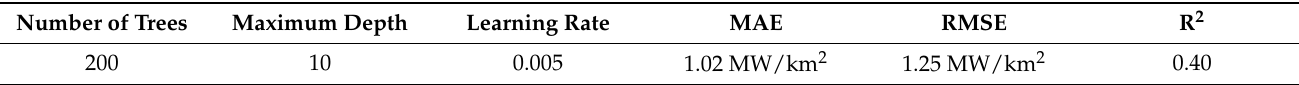
Table 3. Results for the best model including model configuration as determined via hyperparameter optimization and accuracy metrics obtained against an independent test set. Accuracy metrics are mean absolute error (MAE), root mean squared error (RMSE), and r-squared (R 2 ).